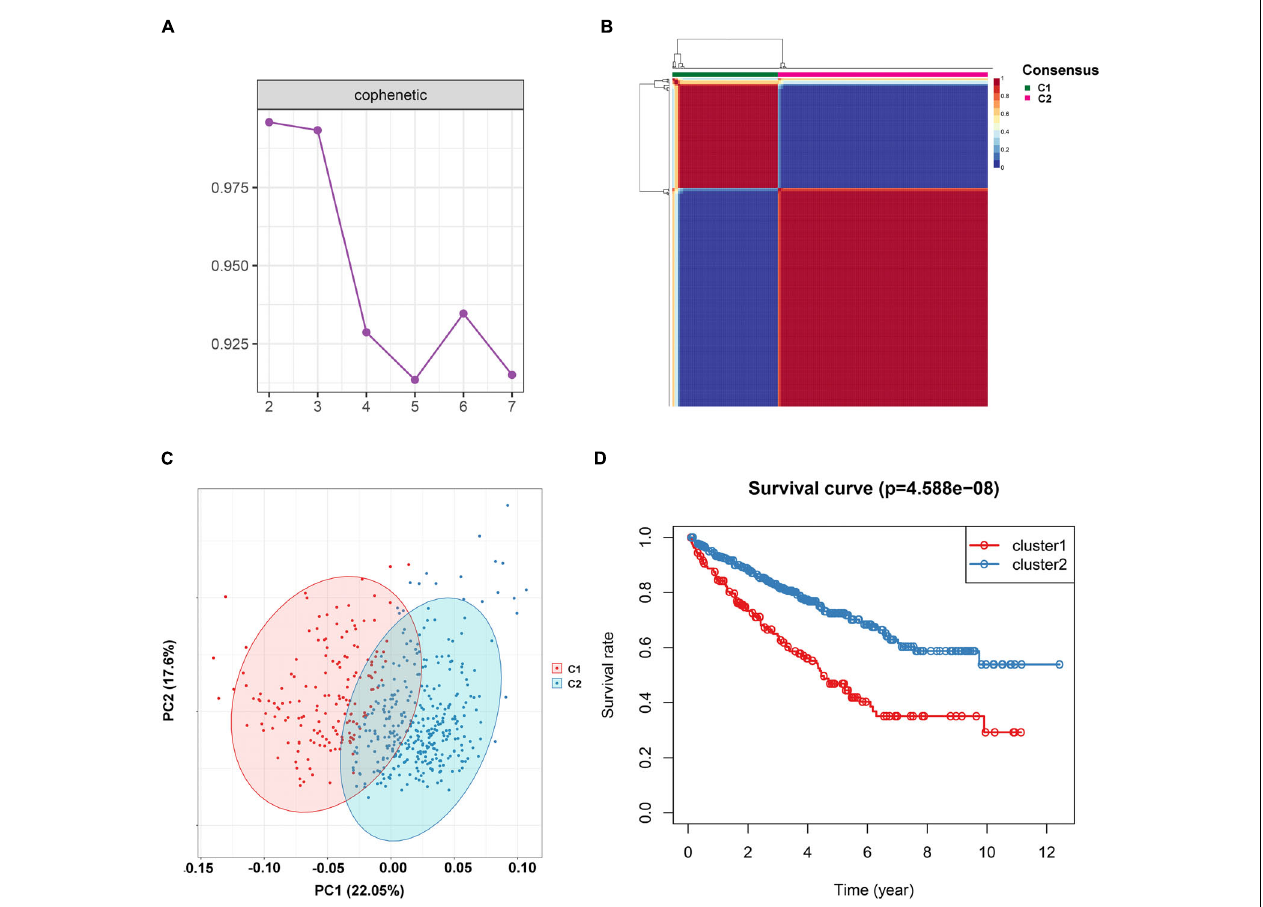
FIGURE 1 | Non-negative matrix factorization clustering analysis to identify potential molecular subtypes of ccRCC based on the immune-related gene expression in TCGA dataset. (A) The cophenetic correlation coefficient for the cluster number from 2 to 7. (B) Consensus matrix heatmap when k = 2. (C) Principal component analysis (PCA) for the 512 ccRCC patients, each dot represents a single sample. (D) KM survival curve analysis for the overall survival of the two subtypes in